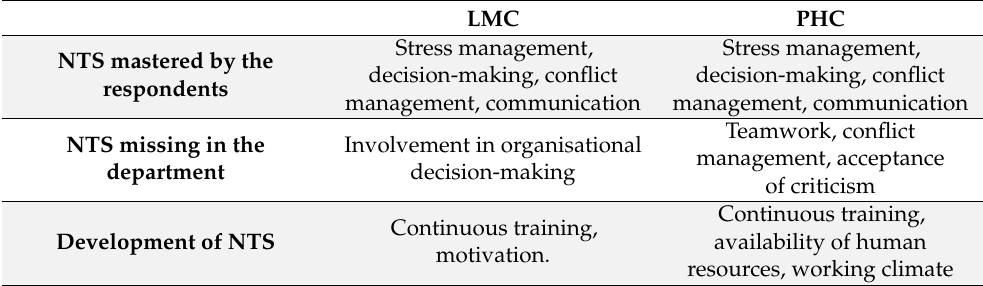
Table 1. Mastered and missing NTS and their development strategy according to the midwives. LMC PHC NTS mastered by